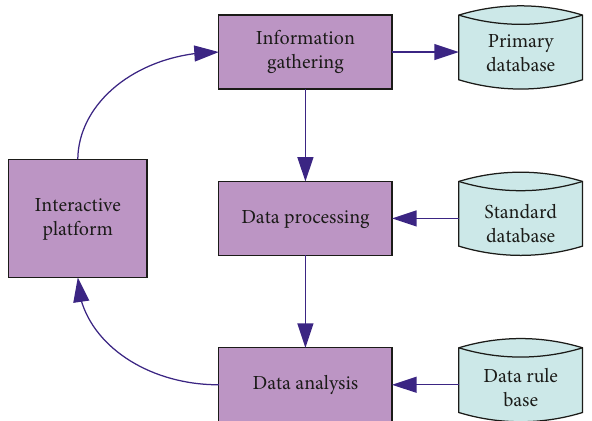
Figure 5: Educational information feature processing process based on data